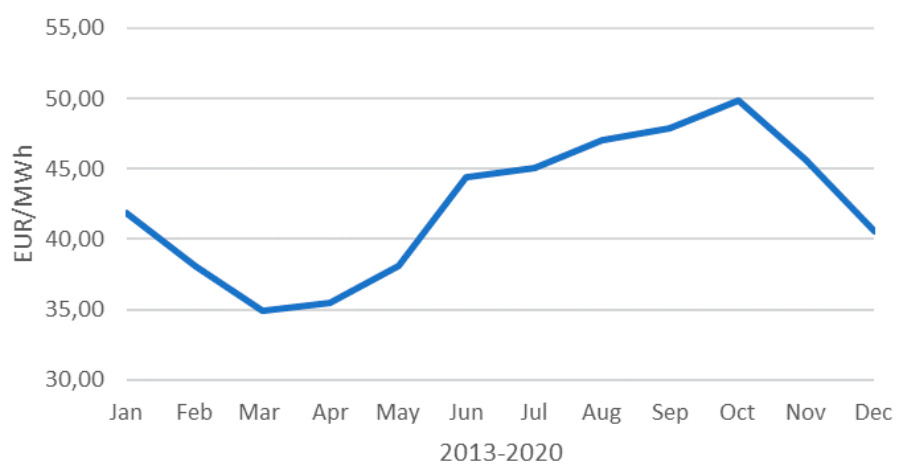
Figure 3. Average electricity power of a private house.